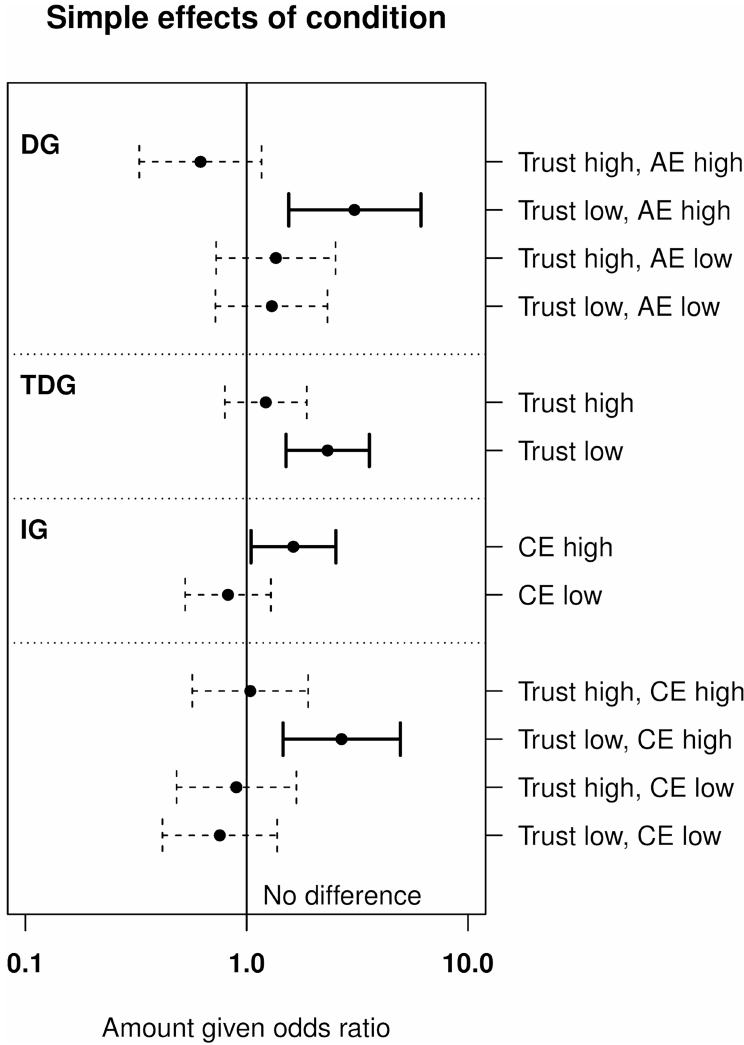
Fig 1. Simple effects of experimental condition on amount given in the economic games for consistent (replicated) interactions. Effect of condition (0 = neutral, 1 = experimental) estimated at high (+ 1 SD) and low ( − 1 SD) levels of moderator variables. Odds ratios and CIs calculated by the exponentiation of log estimates, inferential tests conducted on the log scale, x-axis is on the log scale. AE, affective empathy; CE, cognitive empathy; DG, dictator game; IG, investment game; TDG, triple dictator game. Error bars show 95% CIs. Estimates with solid bold CIs are significant at p < .05.